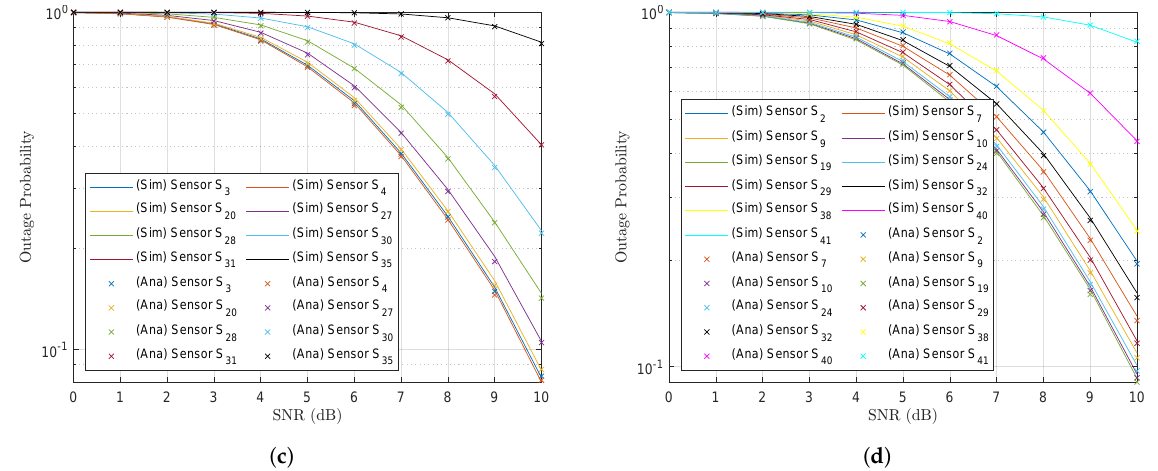
Figure 8. Outage probability at the mobile base station for the UAV’s subcluster trajectory sequence ( a ) C 1 , ( b ) C 3 , ( c ) C 4 and ( d ) C 2 .